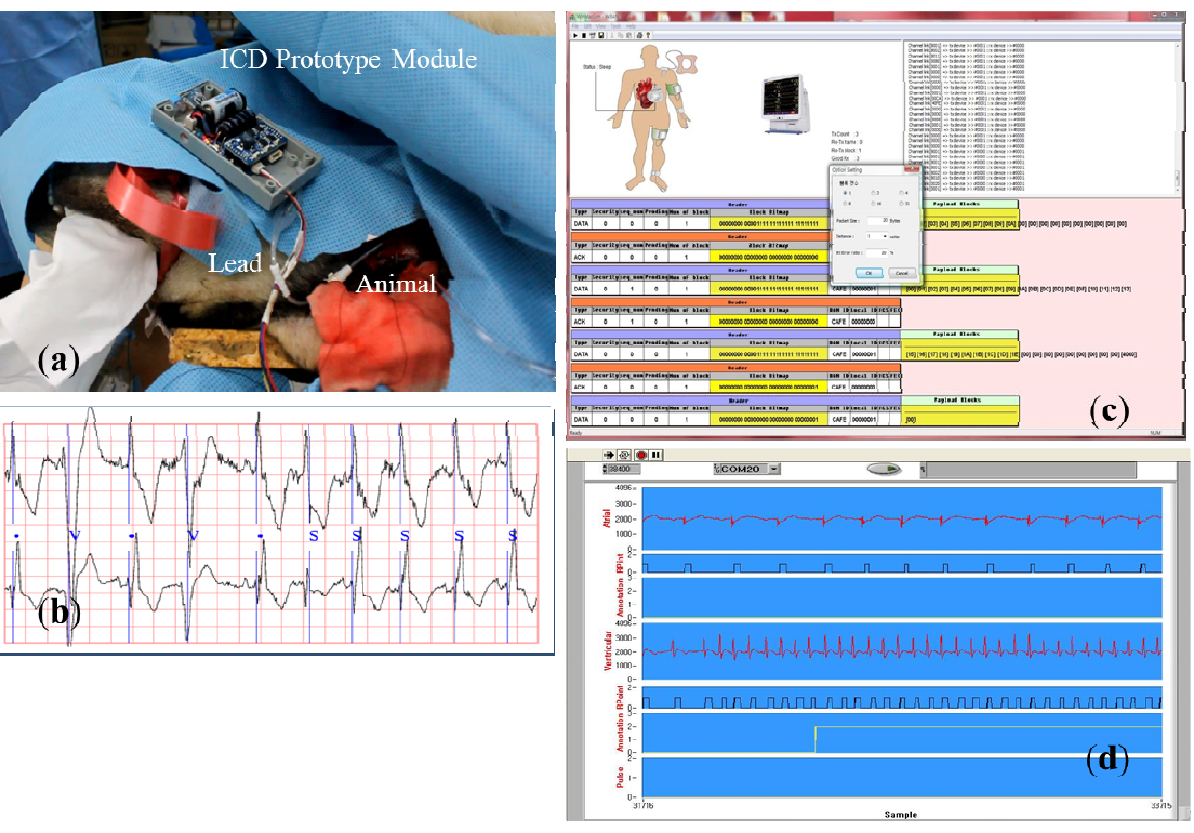
Figure 10. ( a ) Experiment with an animal. ( b ) Detection of ECG/EMG signal. ( c ) MAC frame sniffing. ( d ) Remote monitoring of ECG/EMG signals.